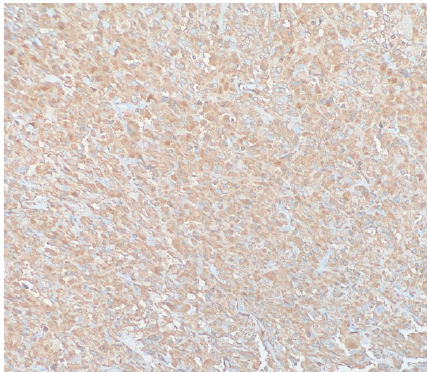
Figure 3: Diffuse cytoplasmic positivity for chromogranin A immunohistochemical staining was present in medullary thyroid carcinoma (10X).